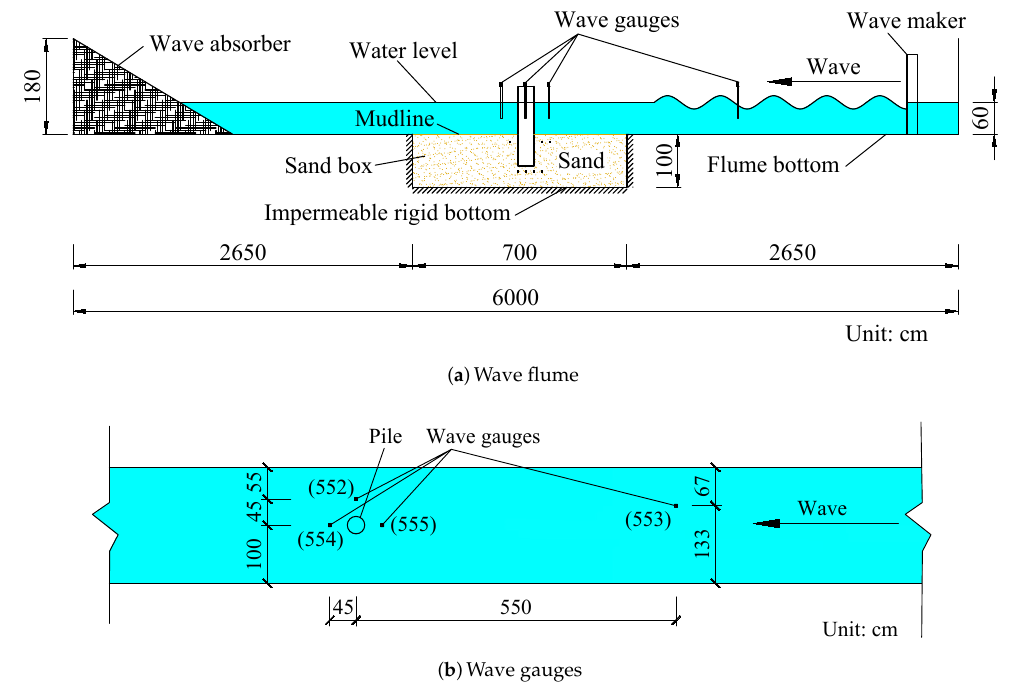
Figure 2. ( a ) Experimental setup for the wave flume and ( b ) the location of wave gauges.